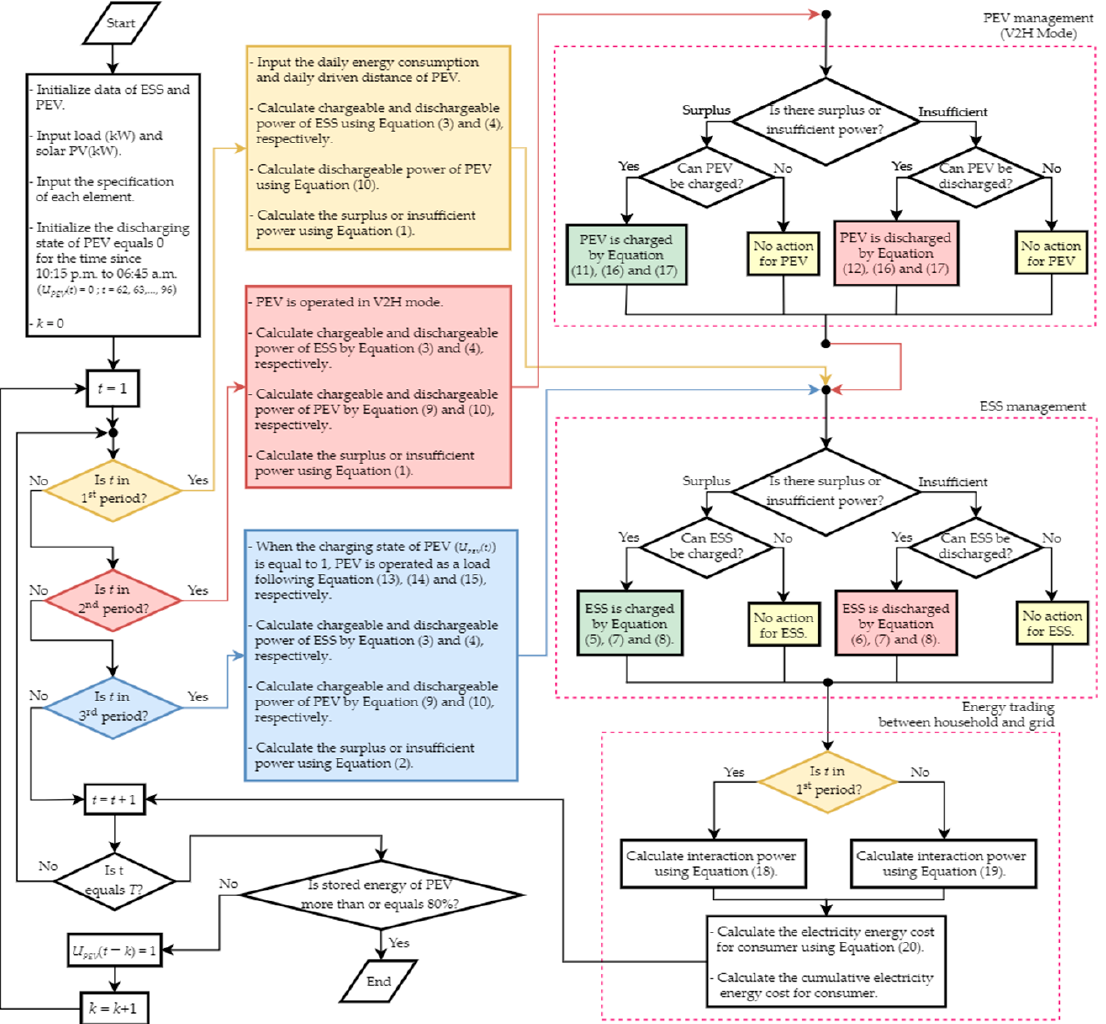
Figure 2. The steps of the proposed home energy management strategy.